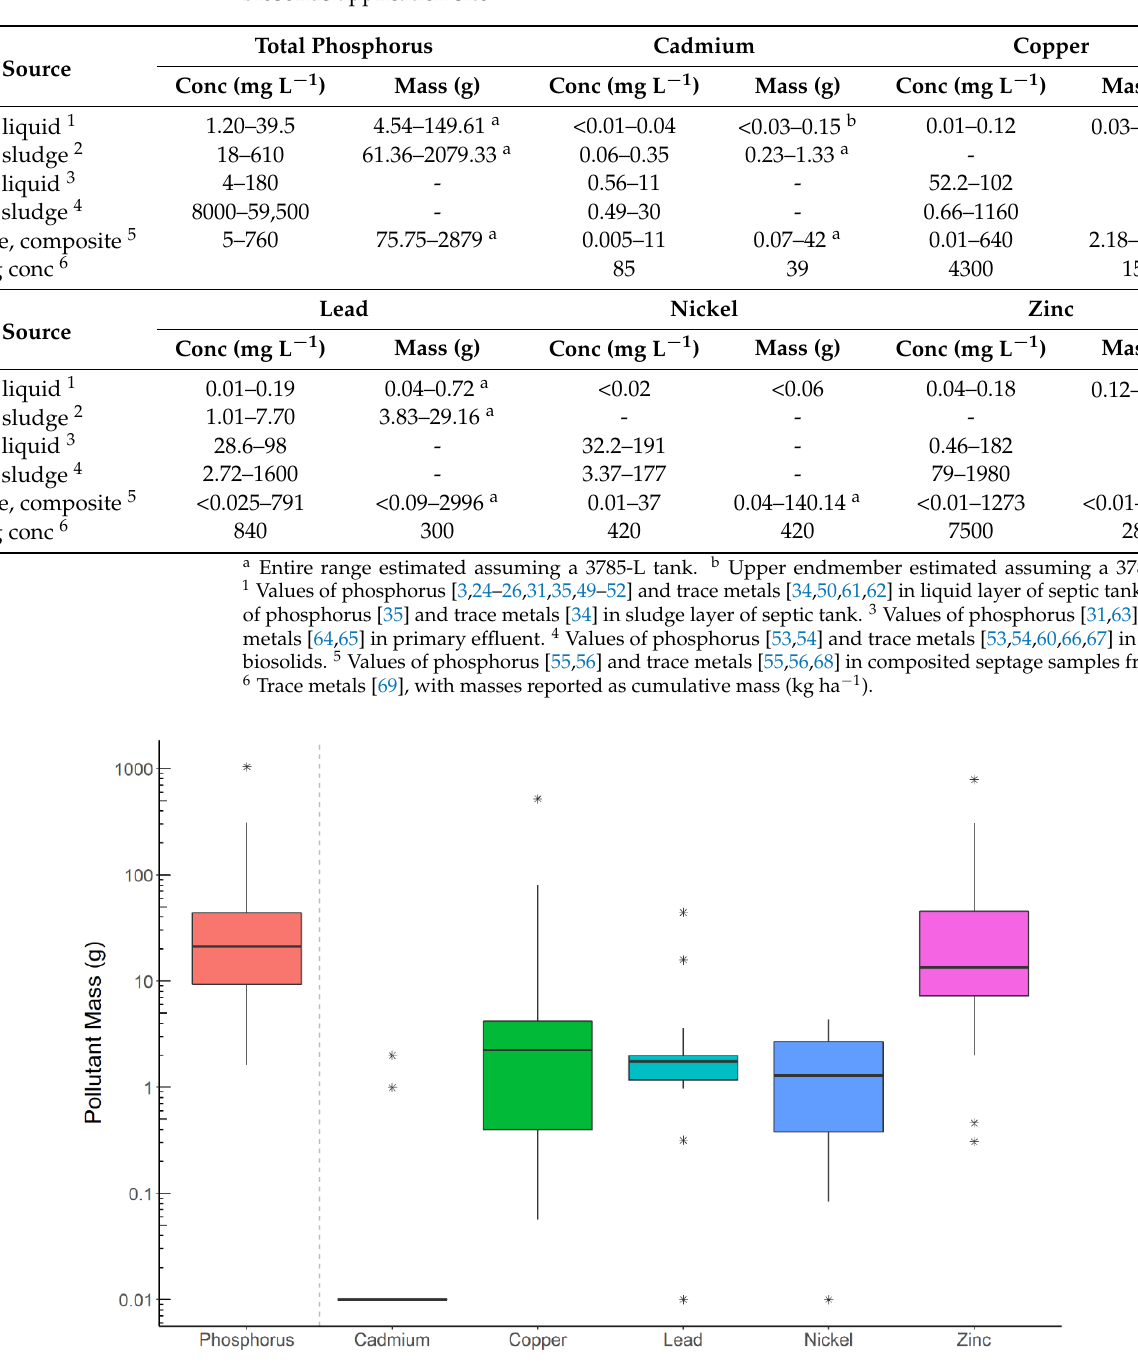
Table 3. Ranges of concentrations (mg L − 1 ) and masses (g) of phosphorus and trace metals from past studies. The ceiling concentration refers to the maximum concentration of a trace metal at the biosolids application site.